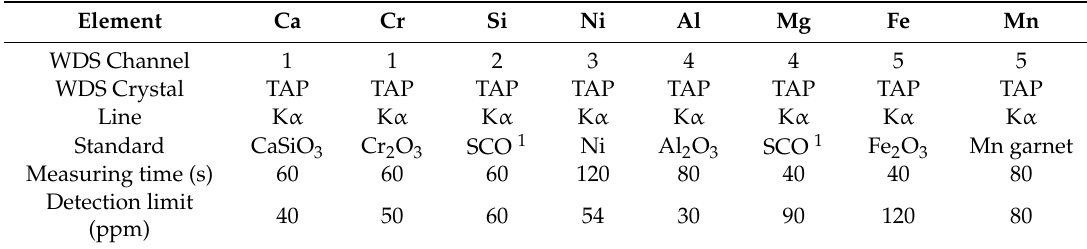
Table 1. Wavelength dispersive spectrometer (WDS) analytical conditions for the quantitative analysis of olivine major and minor element compositions using